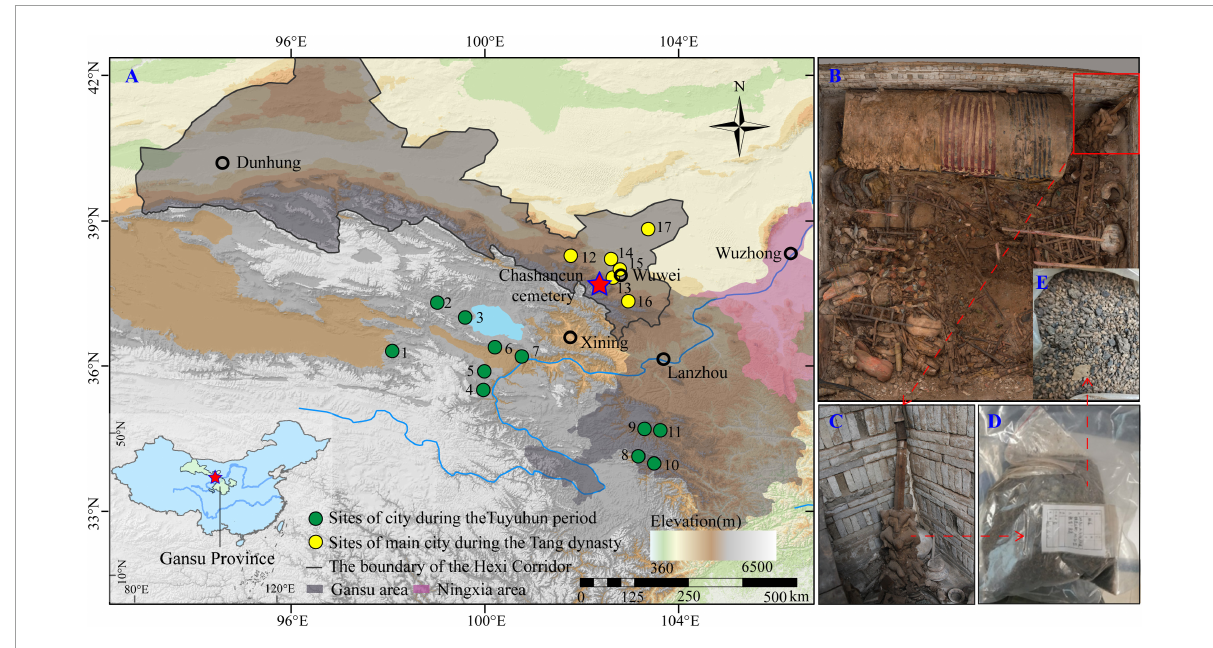
FIGURE1 Location of the Chashancun cemetery (A) and the plant remains in the cemetery (B–E) . 1-Xiangride, 2-Jiamugeertan, 3-Tiebuqia, 4-Xiatang, 5-Zhidongjiala, 6-Qinghaihu, 7-Qugou, 8-Bugang, 9-Niutou, 10-Kaba, 11-Minghe, 12-Tianbao, 13-Guzang, 14-Jialin, 15-Shenniao, 16-Changsong, and